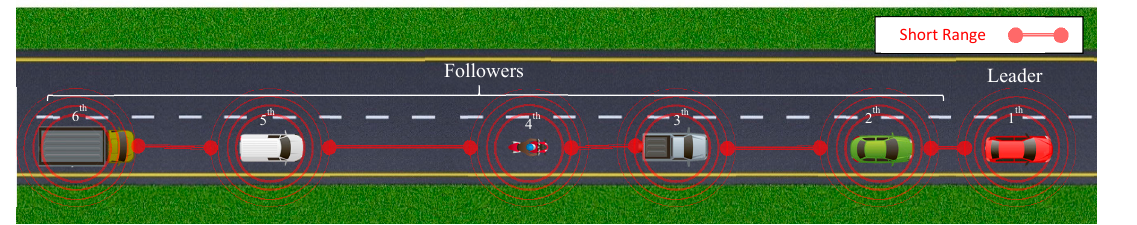
Figure 3. Graph of the standard car-following model.